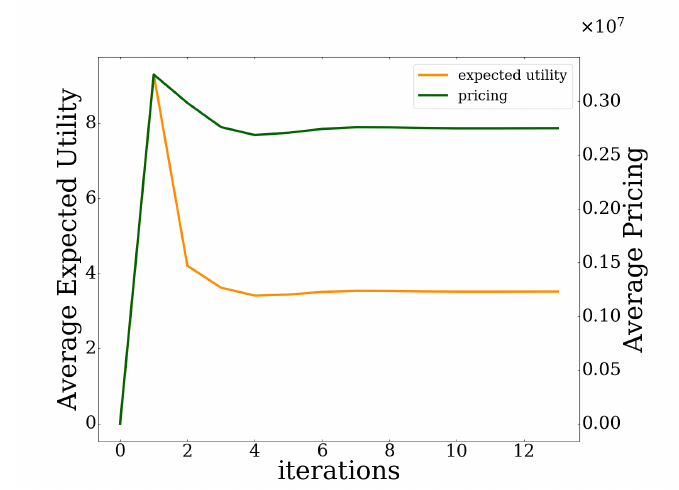
Figure 6. Average users’ expected utility and average users’ pricing vs. iterations.